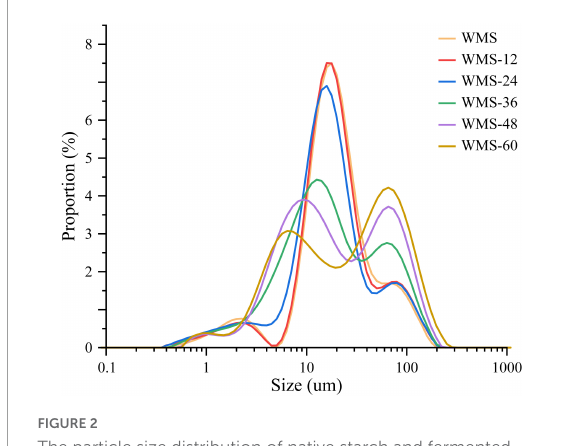
degree of order in starch and the proportion of amorphous to order structure of starch (Cai et al., 2014). The ratio of 1,047/1,022 cm − 1 was increased within 36 h and then decreased, and the difference was insignificant ( Table 2 ), which indicated that the structure of WMS became more order within 36 h. While the ratio of 1,022/995 cm − 1 was increased within 36 h and then obtained a plateau. It demonstrated that a more amorphous region appeared at 36 h during fermentation.